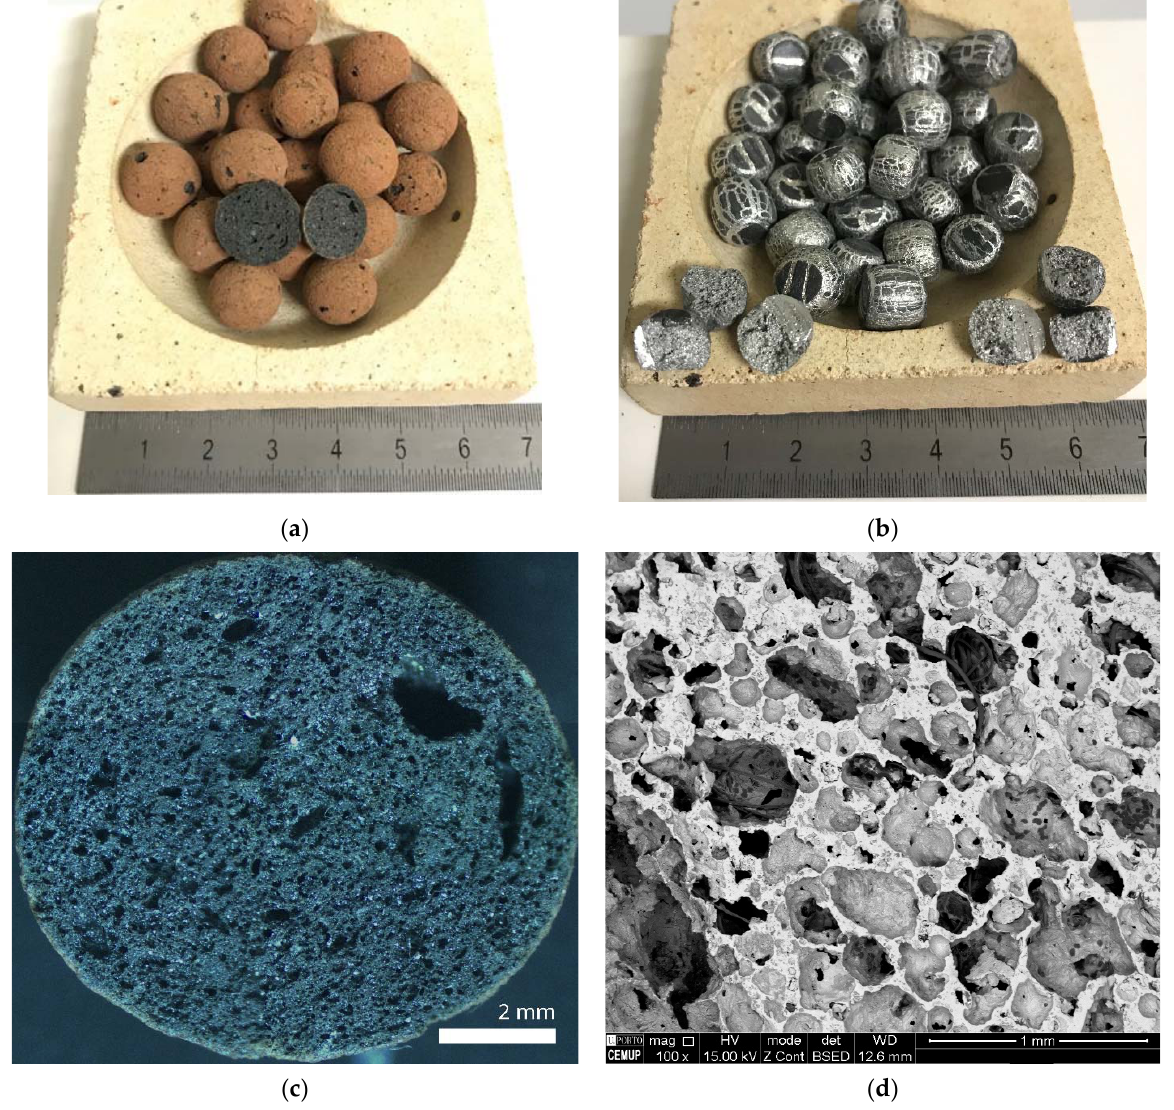
Figure 1. The physical aspect of particles: ( a ) ECn and ( b ) EAn, and porous morphology of ( c ) ECn and ( d ) EAn. Table 1. Physical properties of aluminum and porous clay fillers.